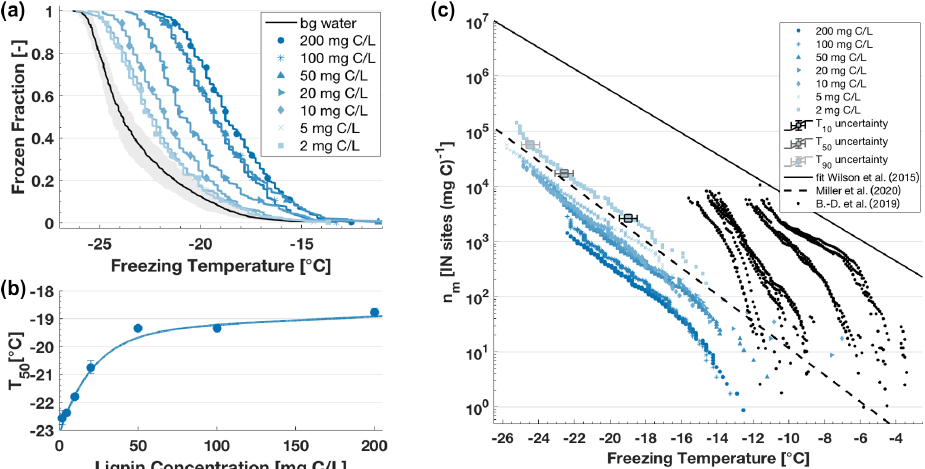
Figure 4. (a) Frozen fraction (FF) curves as a function of temperature for an aqueous dilution series of lignin. The FF curve graph includes the water background (bg water, black line) and its uncertainty range (shaded grey area) representing FINC’s limit of detection (see Fig. S6). The temperature uncertainty in each well is ± 0.5 ◦ C and measurement reproducibility is within this range (see Fig. S7). (b) Median freezing temperature ( T 50 ) of the lignin solution as a function of lignin concentration. The T 50 values include the standard deviation from multiple experiments where applicable ( n ≥ 2) and are fitted with T 50 = − 3 . 7 × exp ( − 0 . 046 × x) − 19 . 46 × exp ( − 0 . 00014 × x) ; R 2 = 0.99. Lignin’s IN activity in this dilution series remains above the water background and increased exponentially with increasing concentration up to an asymptote around − 19 ◦ C, as illustrated by the slope of the T 50 . (c) Ice-active mass site density n m as a function of temperature of the aqueous dilution series of lignin. At T 10 , T 50 and T 90 of the 200mgCL − 1 trace, the freezing temperature x -axis uncertainty of 0.5 ◦ C and uncertainty in n m based on variation in carbon content are included (see also Fig. S8). Note that the y -axis uncertainty is smaller than the limits of the box marker. For comparison, a fit for biogenic particles in sea spray aerosols from Wilson et al. (2015); a lignin parametrization based on 20mgCL − 1 lignin solutions from Miller et al. (2020), where n m = exp ( − 0 . 558 × T − 3 . 12); and n m values from dissolved organic matter (Borduas-Dedekind et al., 2019) are